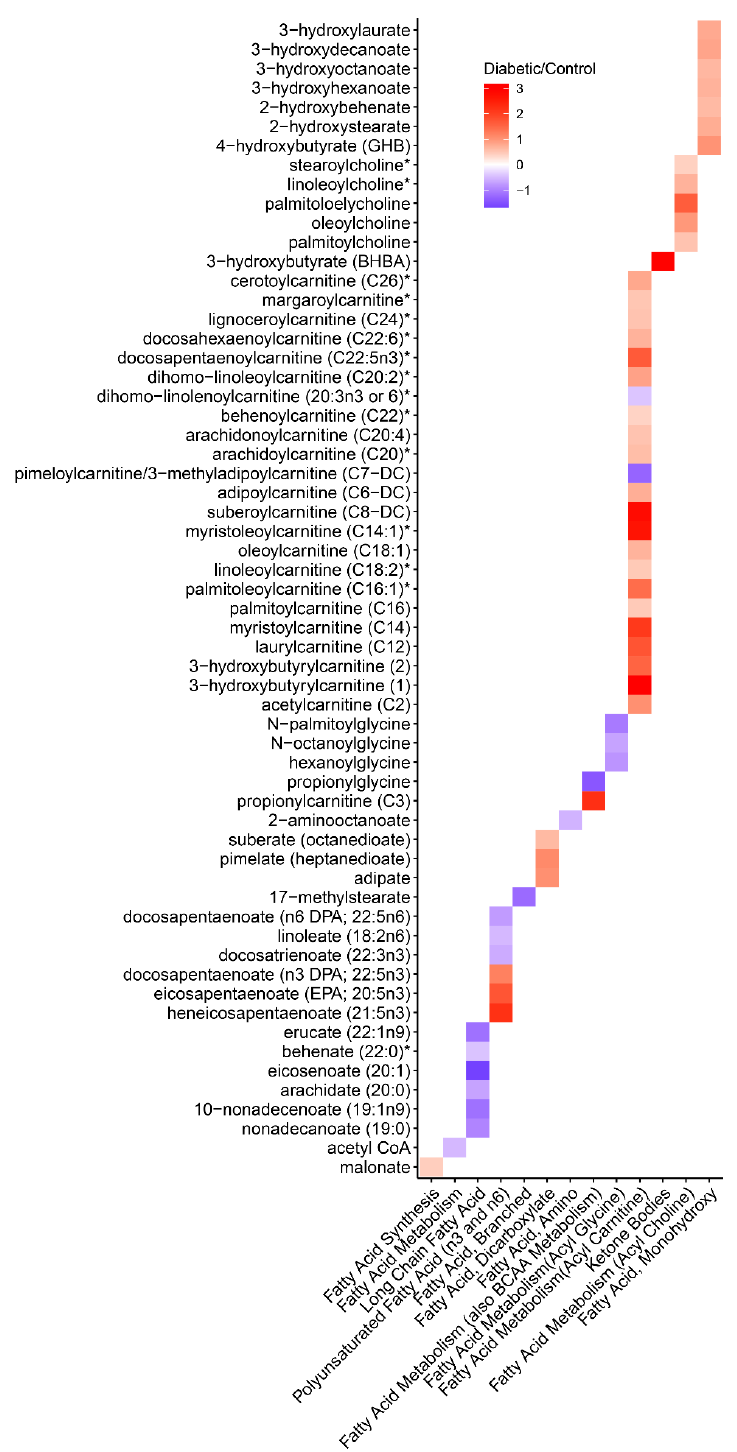
Figure 6. Heatmap of differentially regulated metabolites profiled between diabetic and control mice in fatty acid pathways. X-axis: Biochemicals. Y-axis: Fatty Acid Pathways. Legend represents the log 2 fold changes with red meaning higher concentrations in diabetics and blue meaning lower concentrations in diabetics compared to controls. * Indicates annotated compounds without official confirmation based on a